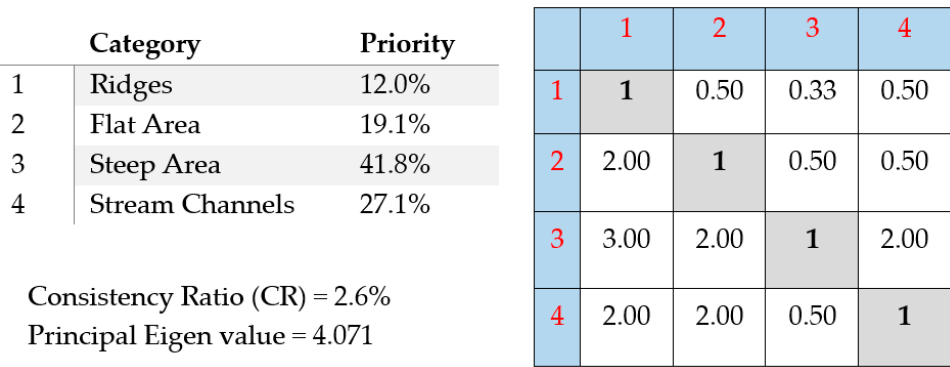
Figure 9. Topographic weights and scoring [32].